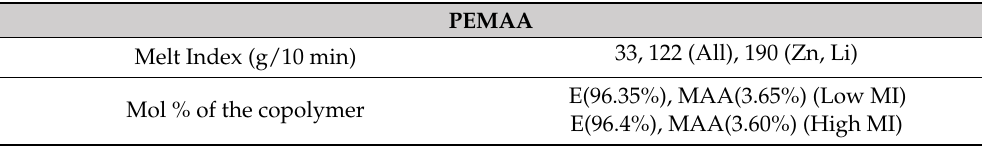
Table 2. Base Ionomer Properties of melt index and mol % of copolymers ethylene (E) and methacrylic acid